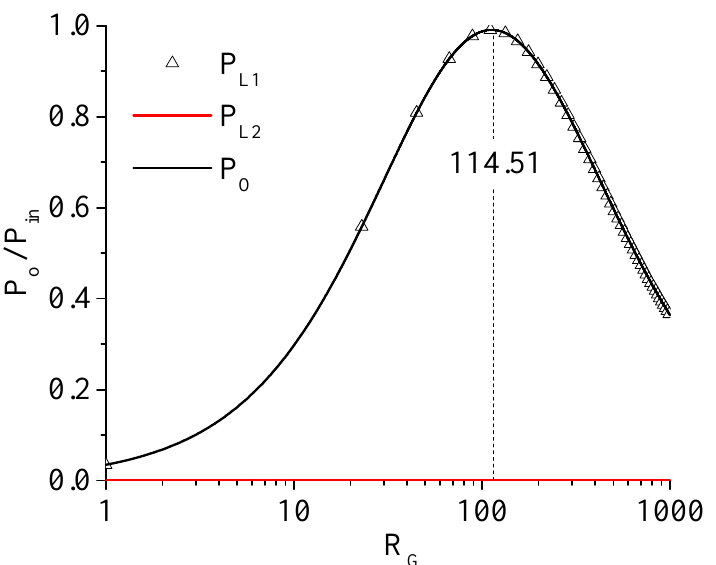
Figure 11. Case 2: output power calculated for Case 2 by varying the resistive part of the impedances of the generators, R G